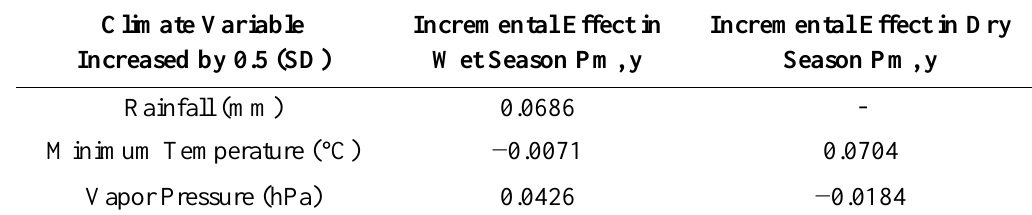
Table 1. Modeled predictions of climate variable influence on diarrheal disease incidence (presented as a proportion deviation from yearly mean, Pm,y) are illustrated by increasing each variable respectively by one half of a standard deviation (SD) from the mean seasonal value while holding all other variables